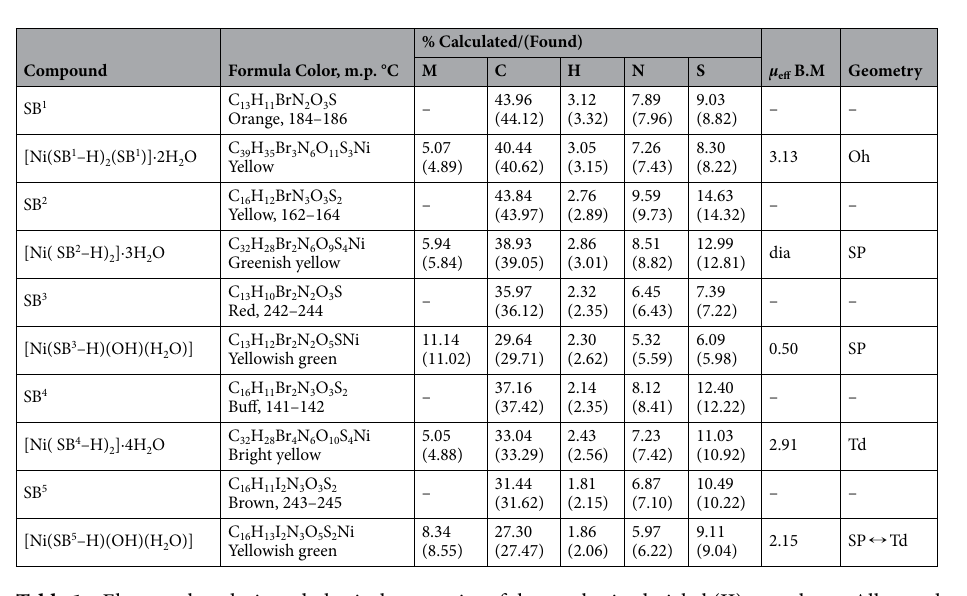
Table 1. Elemental analysis and physical properties of the synthesized nickel (II) complexes. All complexes have m.p. > 300 °C.